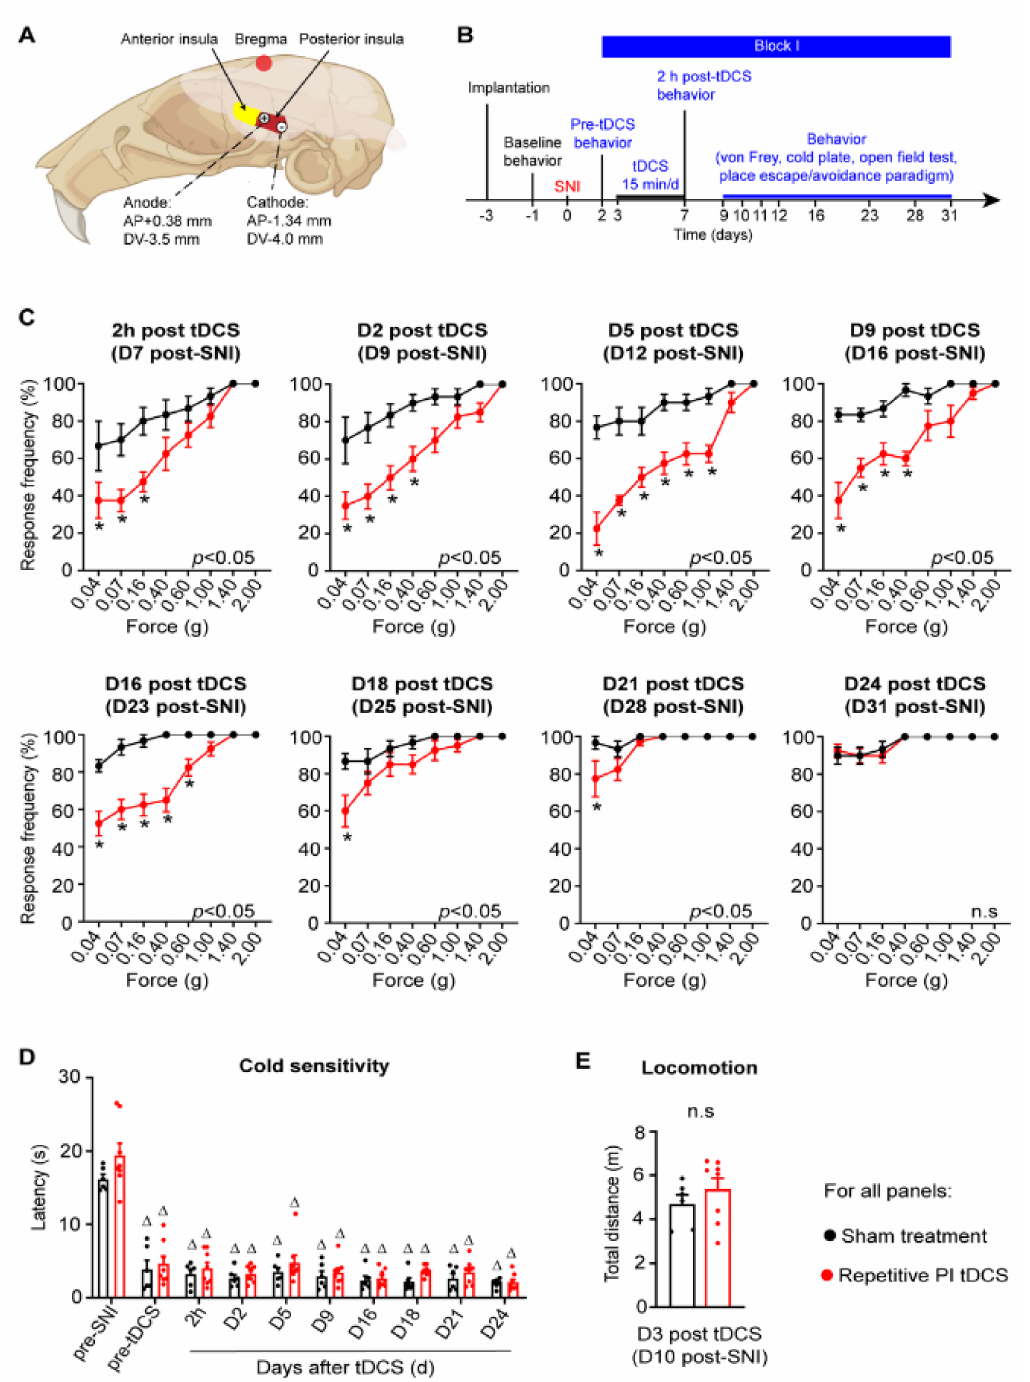
Figure 1. Effects of repetitive transcranial direct current stimulation applied to the posterior insula (PI tDCS) on mechanical sensitivity, cold sensitivity and locomotion in mice over the development of neuropathic pain. ( A ) Schematic illustration of the placement of ectrodes over the temporal skull